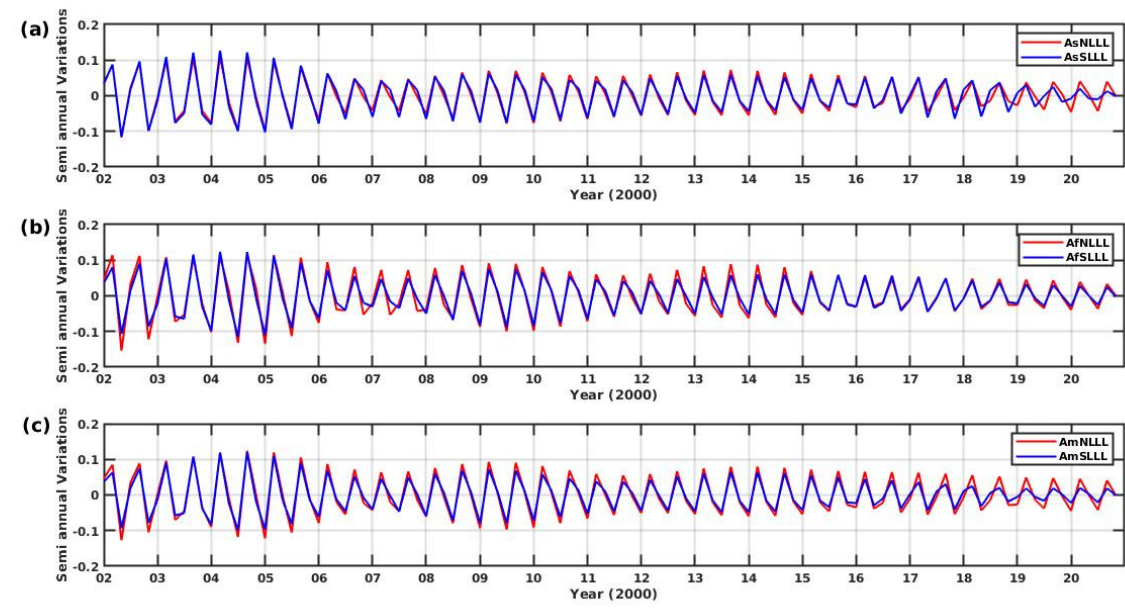
Figure 6. Similar to Figure 3a but for sectors of ( a ) Asia, ( b ) Africa, and ( c ) America.